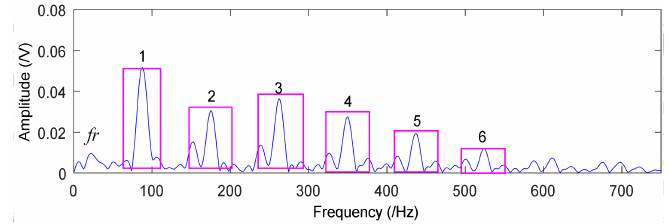
Figure 27. The diagonal slice spectrum after noise reduction using standard local projection.